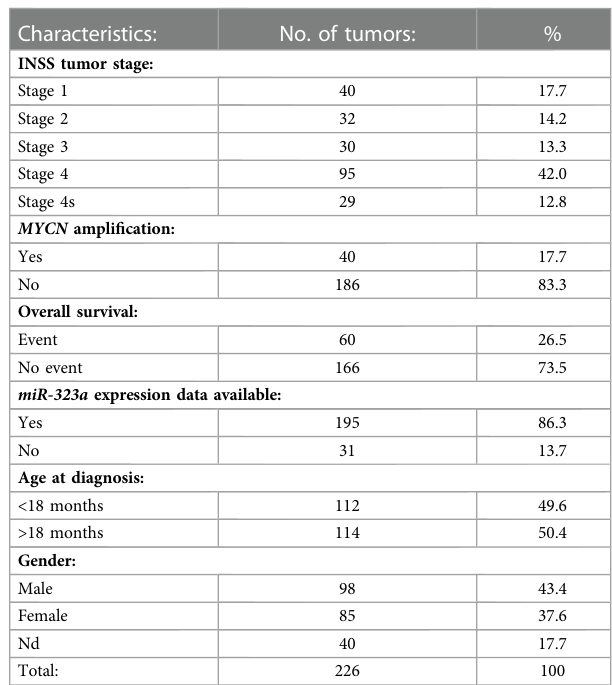
TABLE 1 Characteristics of primary neuroblastoma tumors from NRC-226 dataset.